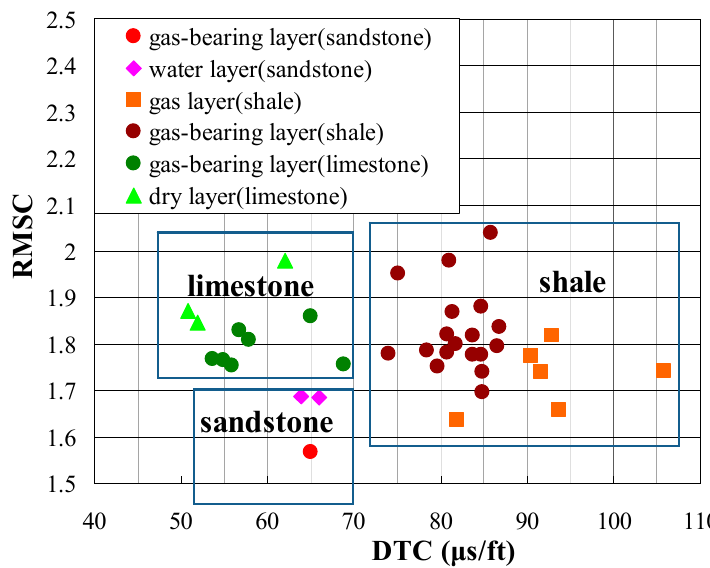
Figure 2. The plot for RMSCs of different types of reservoirs in some block of China (data from the south Sichuan area of Sichuan Basin, provided by the laboratory of Sinopec Oilfield Service Corporation).